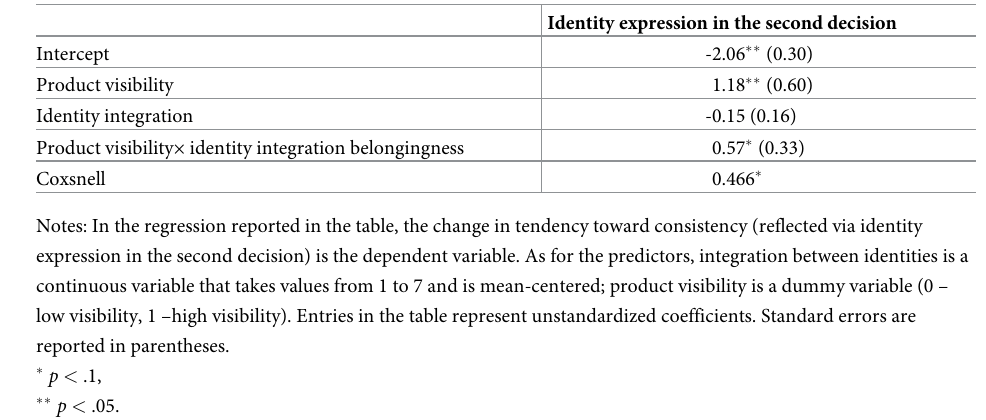
Table 1. The effect of expected visibility conditions (High vs. Low) and integration between identities on consis- tent behavior (Experiment 4).